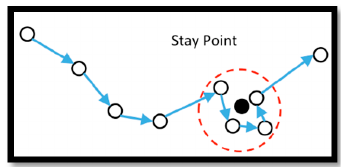
Figure 4. Stay point where the users have stayed for a while at (almost) the same location.